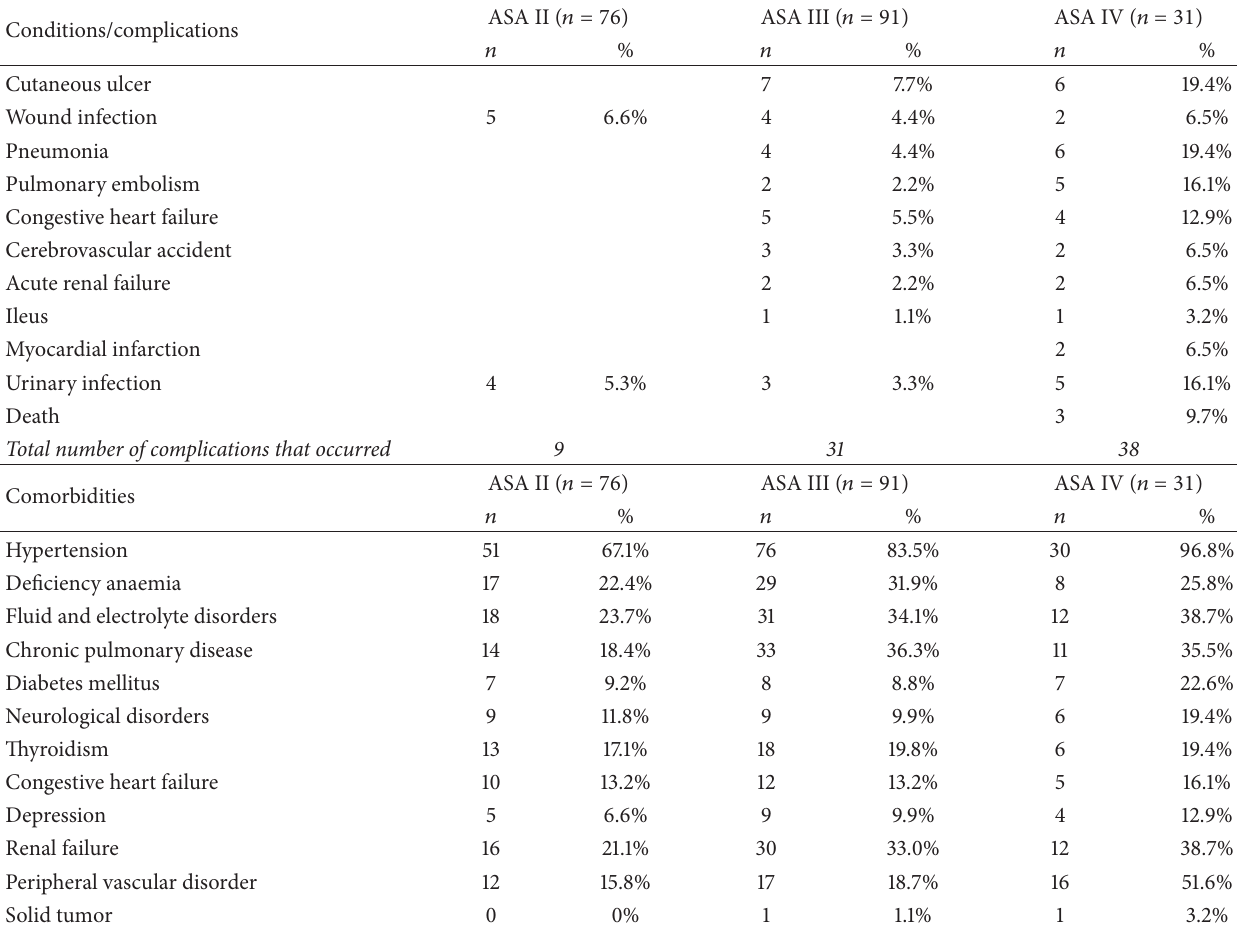
Table 2: Comorbidity profile and complications of hip fracture cohort categorized by the ASA score. Many patients have more than one comorbidity or